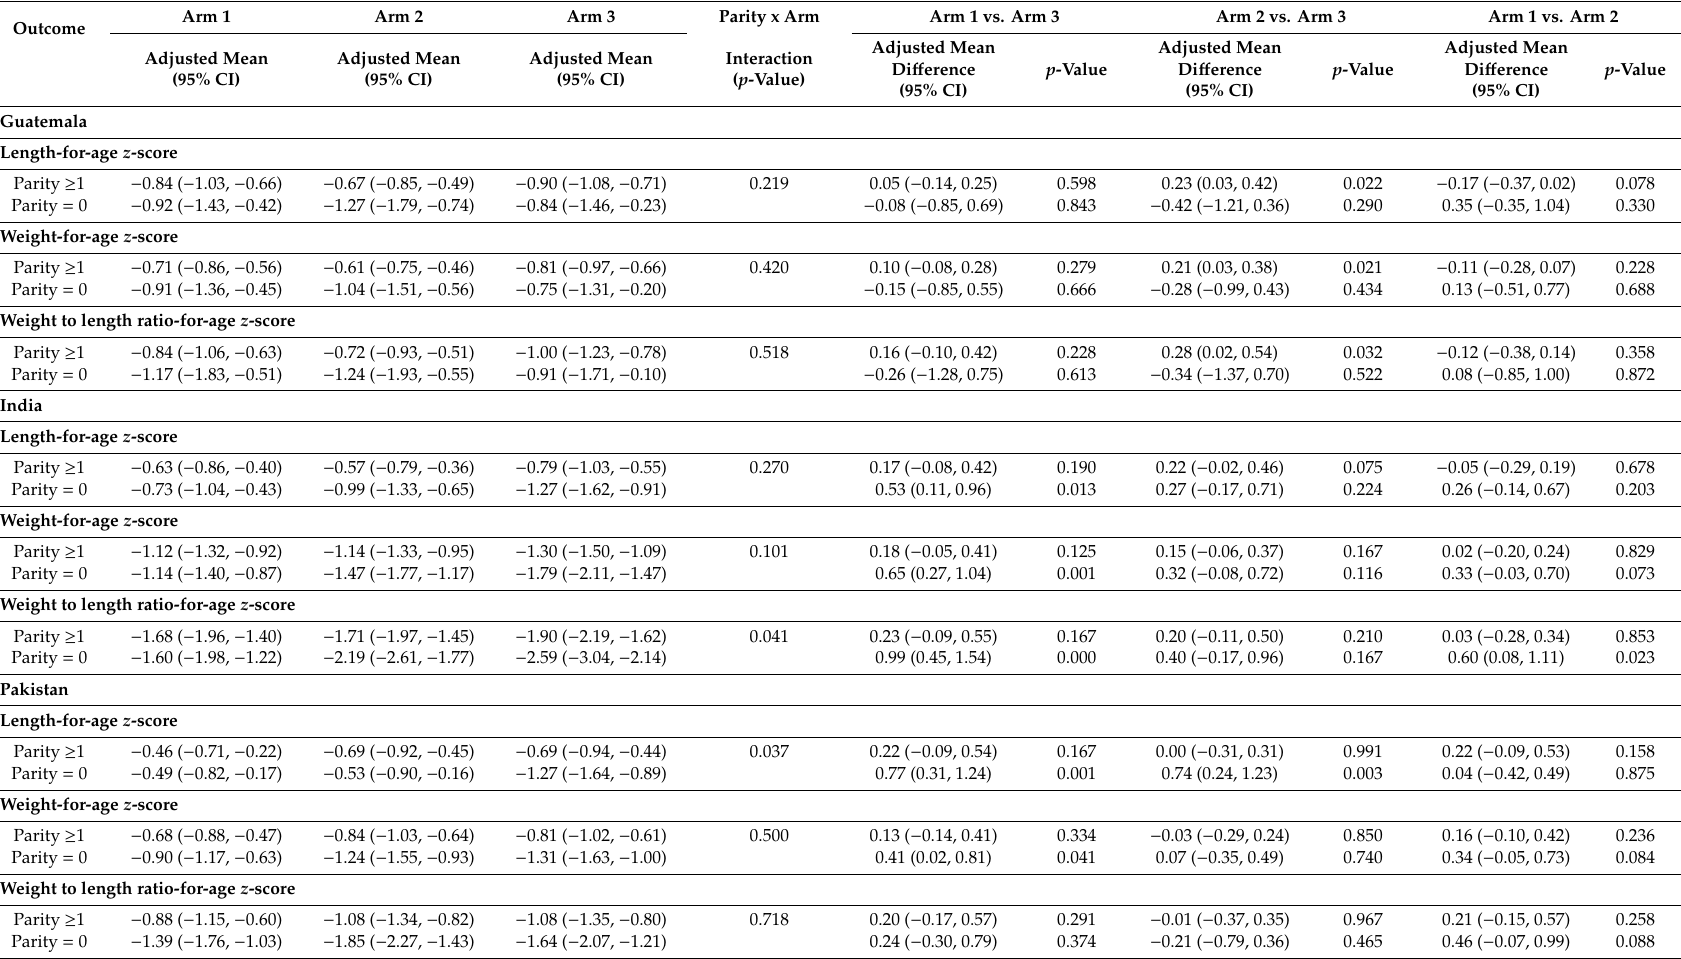
Table 4. Regression results of neonatal anthropometry by parity: individual site